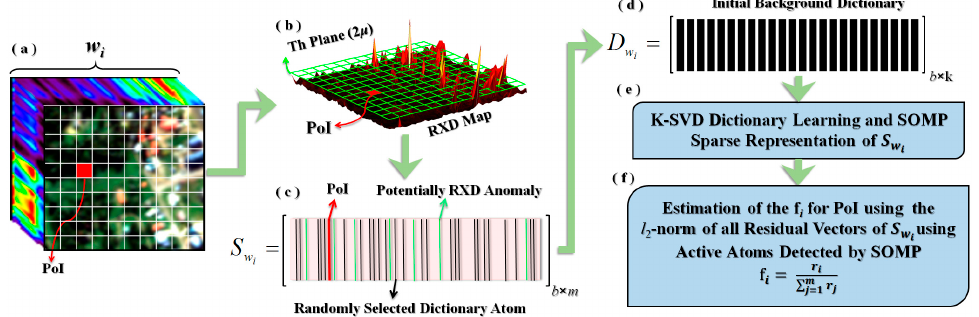
Figure 2. The process of the proposed anomaly detection algorithm.